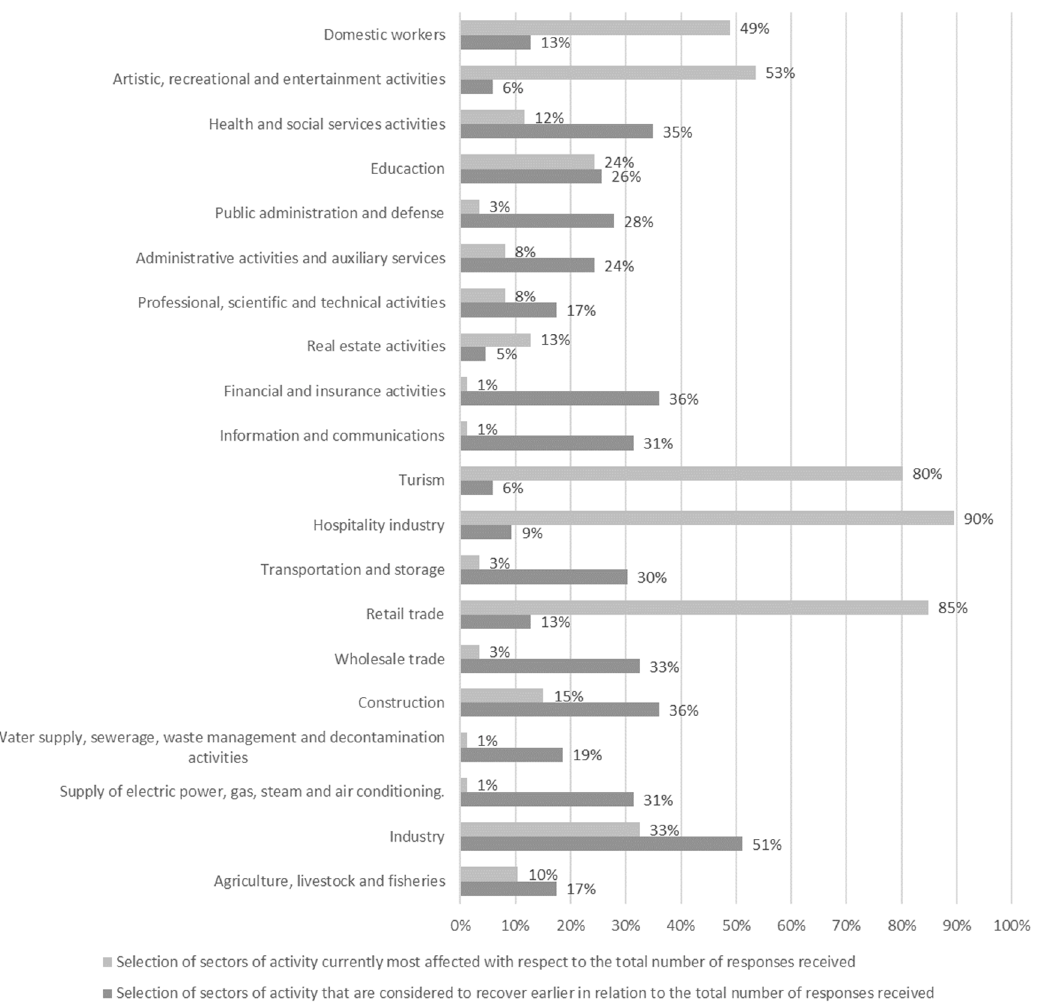
Figure 5. Comparison between sectors considered to be the most adversely affected in terms of those expected to recover first.